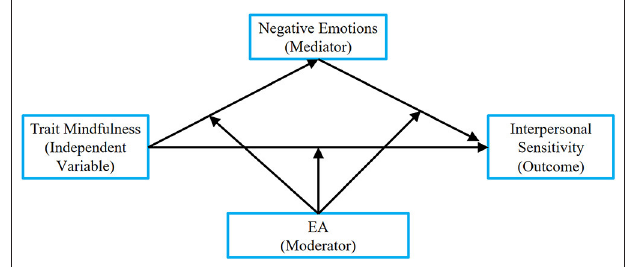
FIGURE 1 | The conditional process